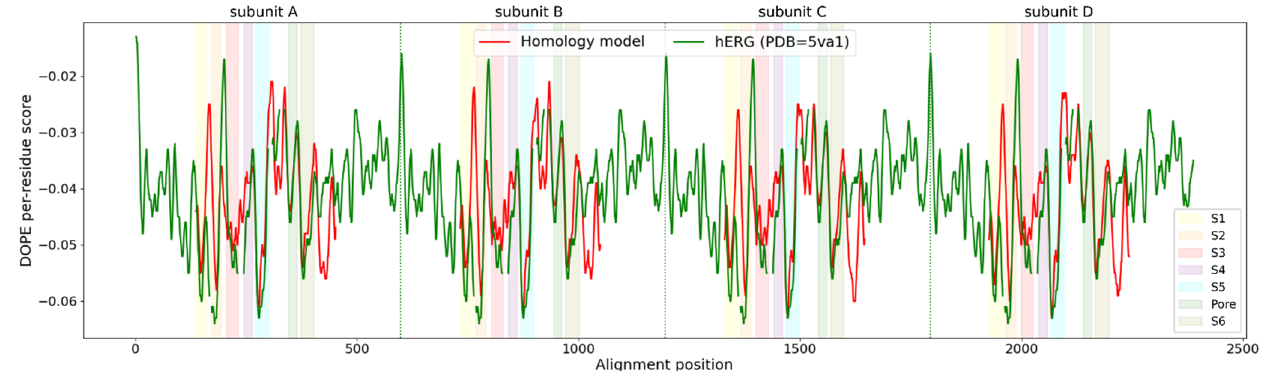
Figure 2. Evaluation of the selected homology model using MODELLER 9.21 DOPE scoring function. Green line, (PDB: 5VA1) DOPE per residue score for hERG used as template; red line, DOPE per residue score of the K V 10.1 homology model created and used in this study. The different color zones represent the S1 to S6 transmembrane segments and the pore domain: S1, yellow; S2, orange; S3, red; S4, purple; S5, blue; S6, brown; pore domain, green. Vertical green dotted lines divide subunits A, B, C, and D. High root mean square fluctuation values in the white zones represent amino acids that are not in the transmembrane part, but in the intracellular and extracellular loops.